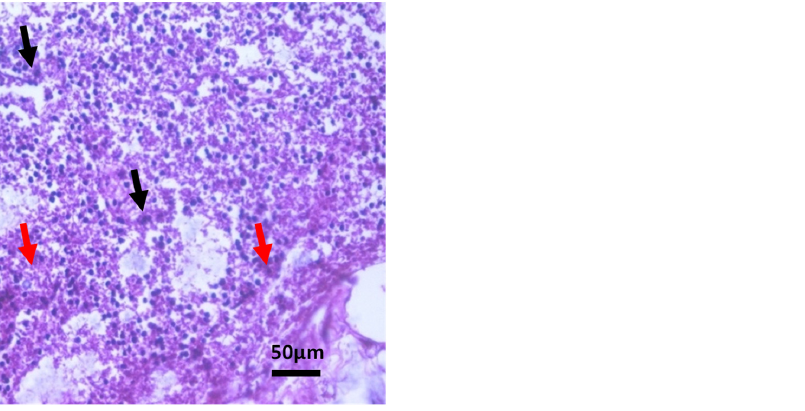
Figure 15. Sections treated with N. graveolens extract showed a scattered sheet of epithelial cells with rounded nuclei with an increased nucleocytoplasmic ratio ( black arrow ), with many degener- ated/necrotic and/or apoptotic cells ( red arrows ) (HE, ×400).